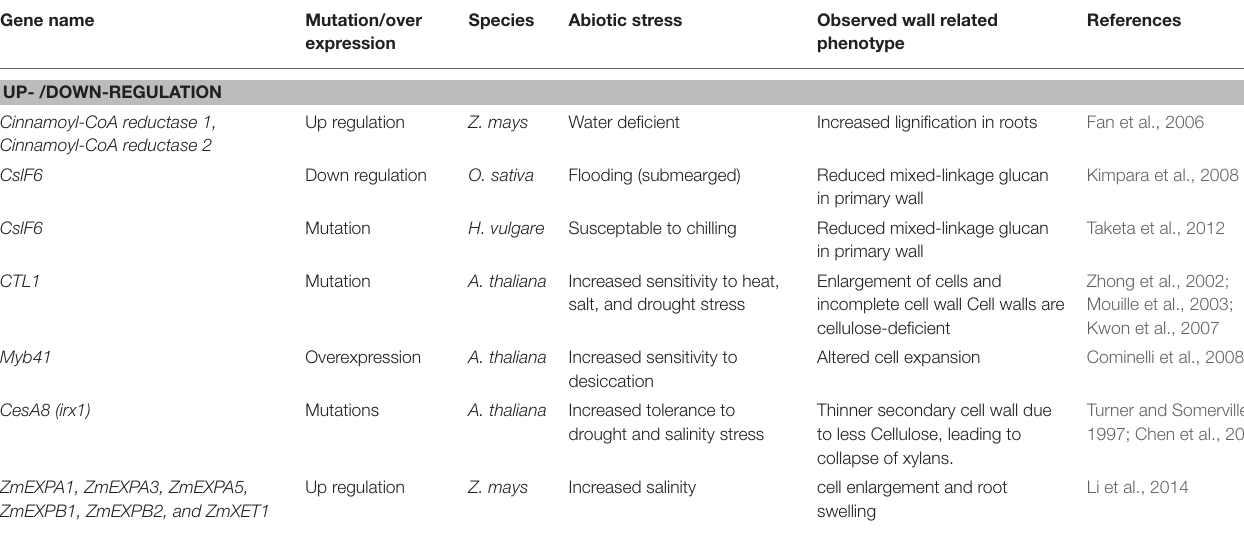
TABLE 3 | Plant: abiotic stress response phenotype with altered cell wall